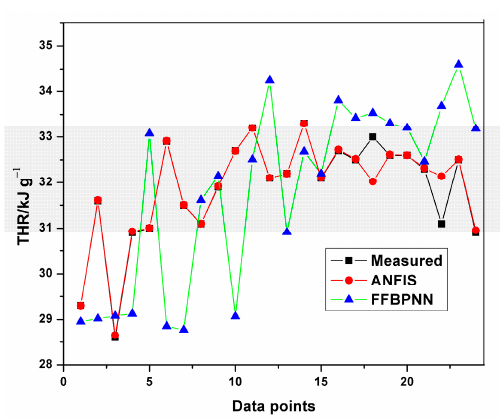
Figure 13. Comparison of HRC testing results.